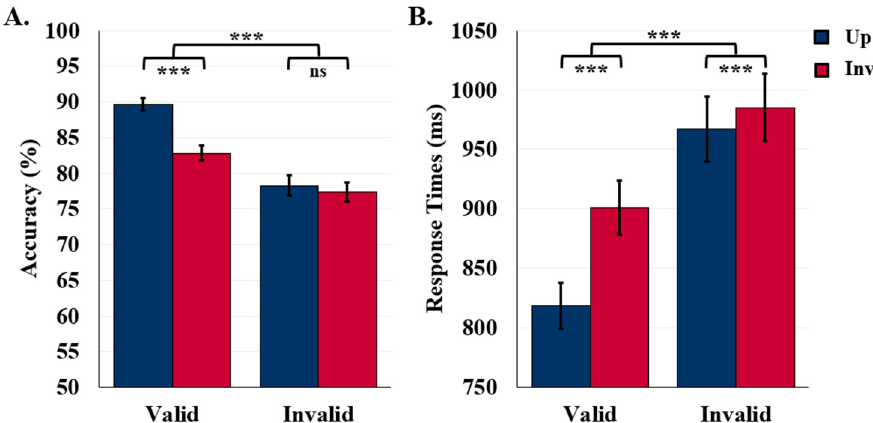
Figure 6. Results for Study 2: Invalid SSC Labels. ( A ) Object Detection Accuracy ( N = 113) and ( B ) detection RTs ( N = 103). Error bars represent standard errors. *** indicates p < 0.001 and ns indicates non-significance.